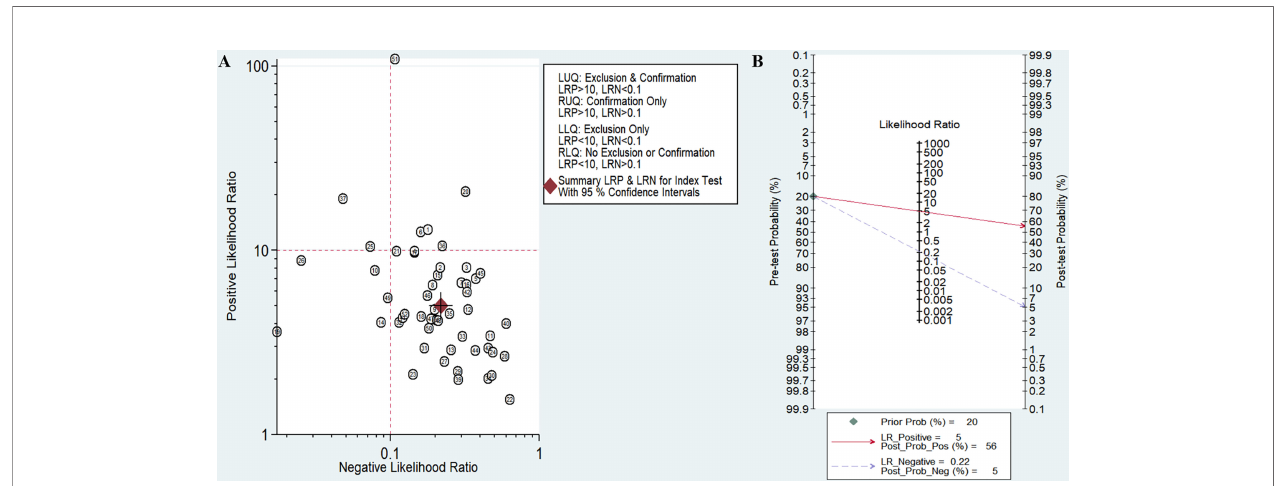
FIGURE 5 | Assessment of clinical applicability of miRNAs for diagnosis of diabetic retinopathy (DR). (A) Summary of positive likelihood ratio and negative likelihood ratio for diagnosis of DR; (B) Fagan ’ s nomogram of miRNA studies for diagnosis of